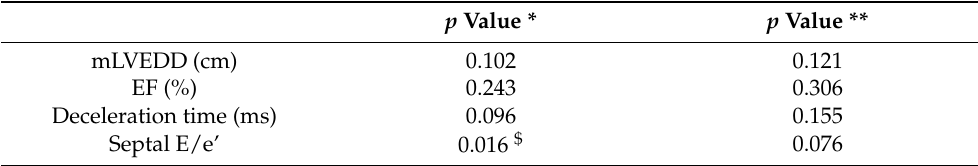
Table 4. Two-way repeated measures ANOVA model to identify factors associated with IDH over